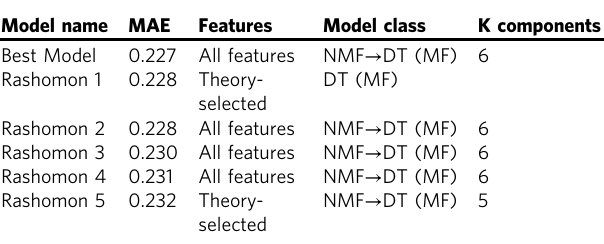
Table 2 The Rashomon